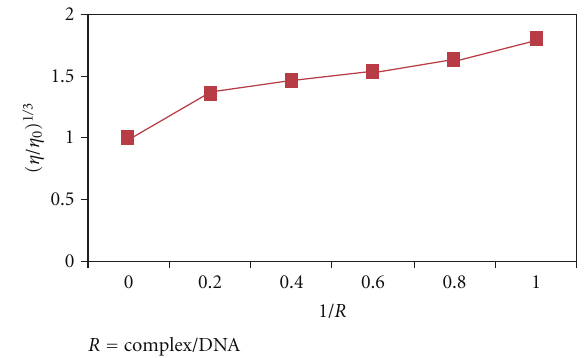
Figure 2: E ff ect of increasing amounts of iron complex on the viscosity of calf thymus DNA (5 × 10 − 5 M) in 10mM Tris HCl bu ff er (ri = 0.2, 0.4, 0.6, 0.8, and